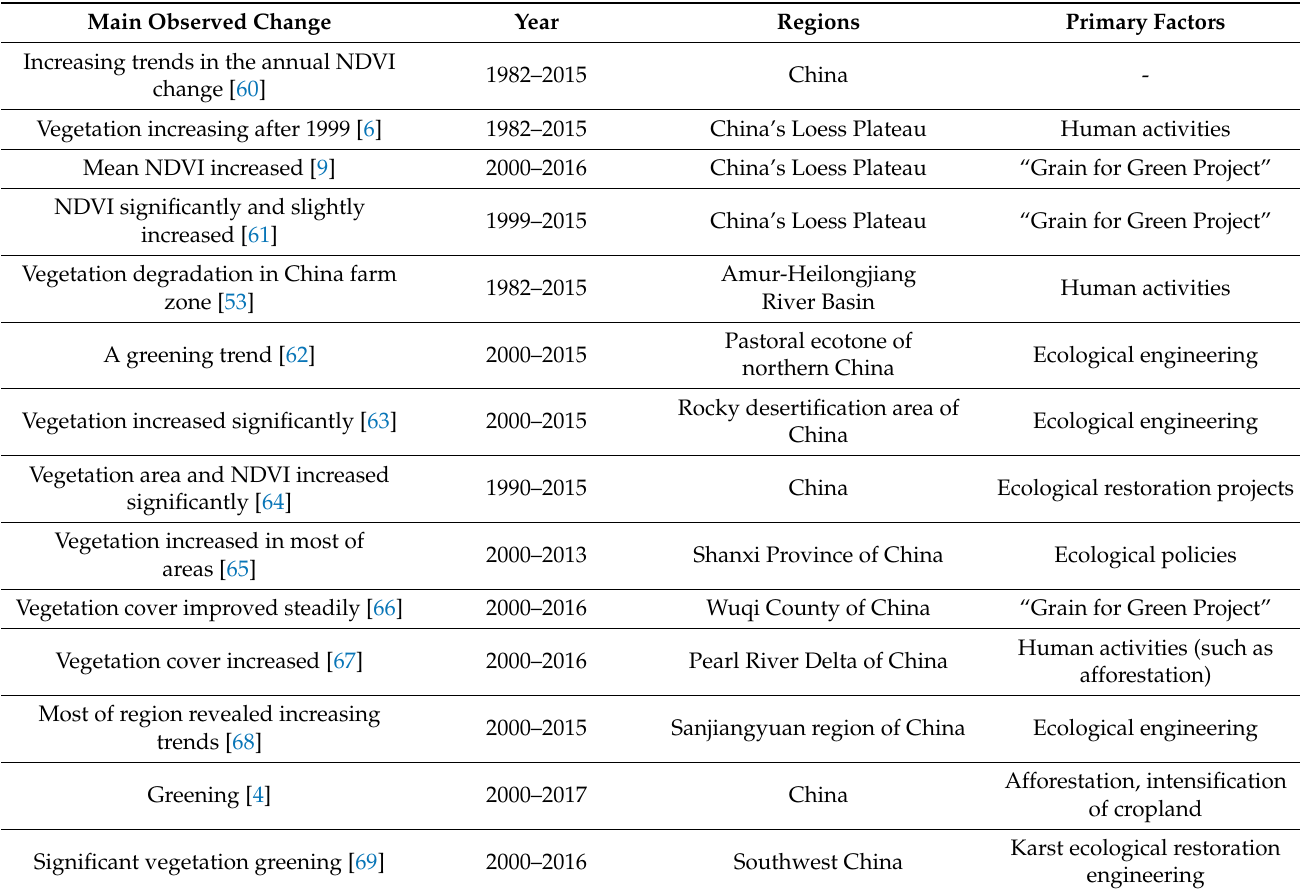
Table 1. Effects of ecological policies and activities implemented by government on vegetation